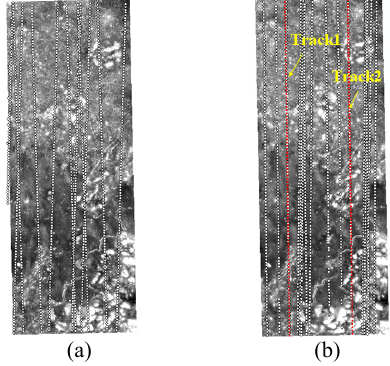
Figure 7. The registered Chang’E-1 (a) and SELENE laser altimetry data (b) directly overlaid on the Chang’E-1 images (backward images) at the Apollo 15 landing site, respectively